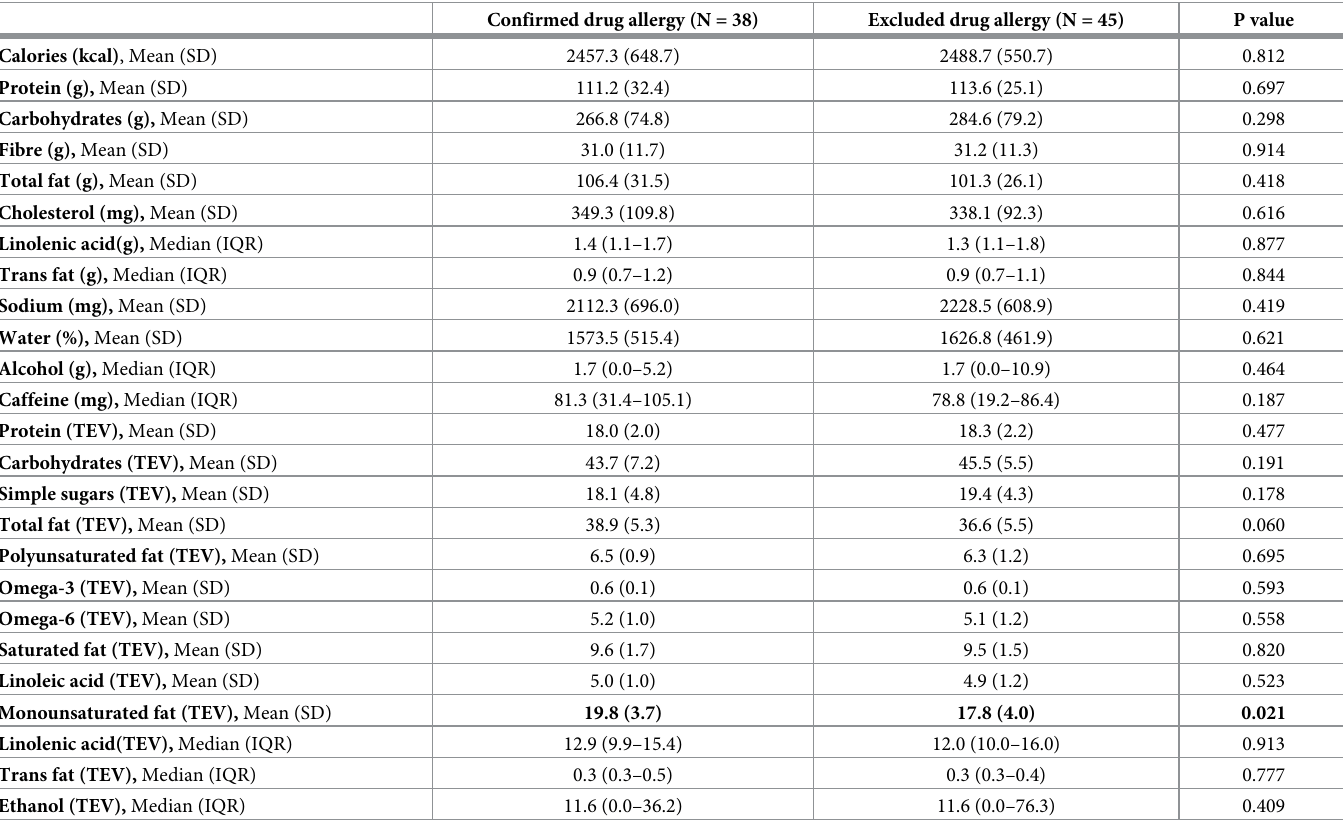
Table 4. Macronutrients intake and drug allergy